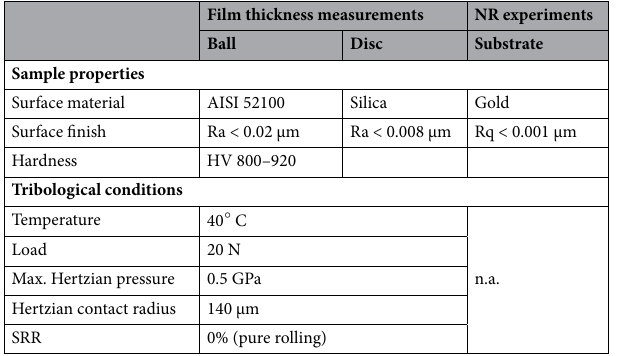
Table 1. Test materials and